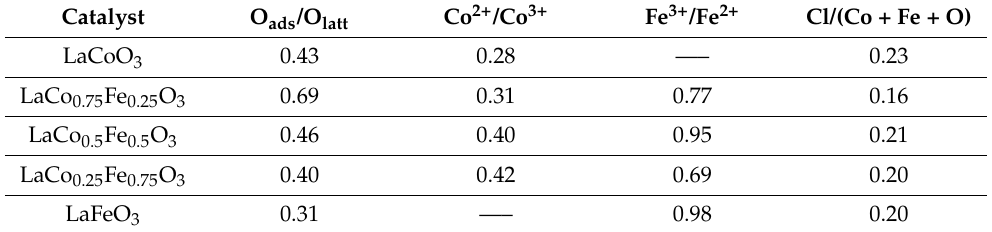
Table 8. XPS pos-reaction results.